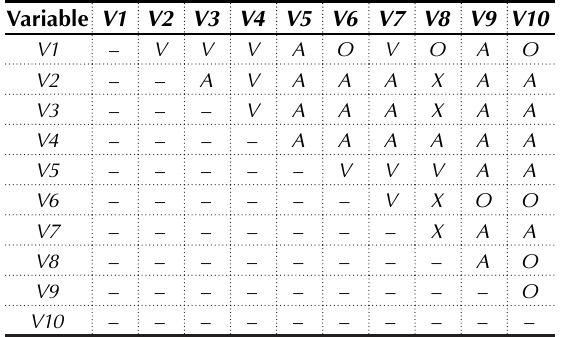
Table 4. Self-Structured Interaction